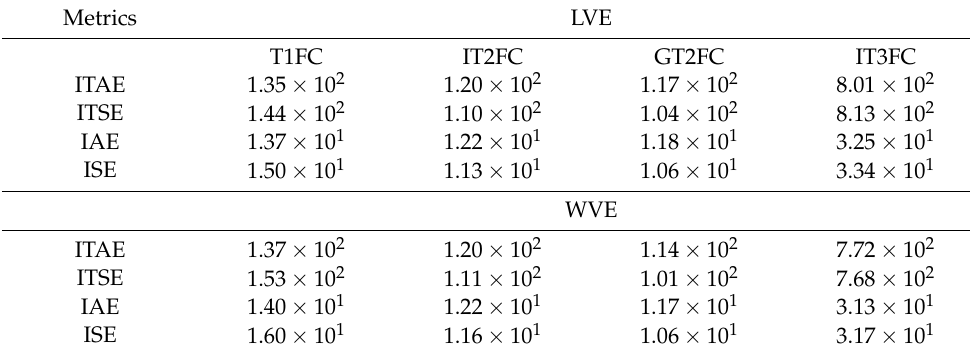
Table 8. Metrics results with BLW.